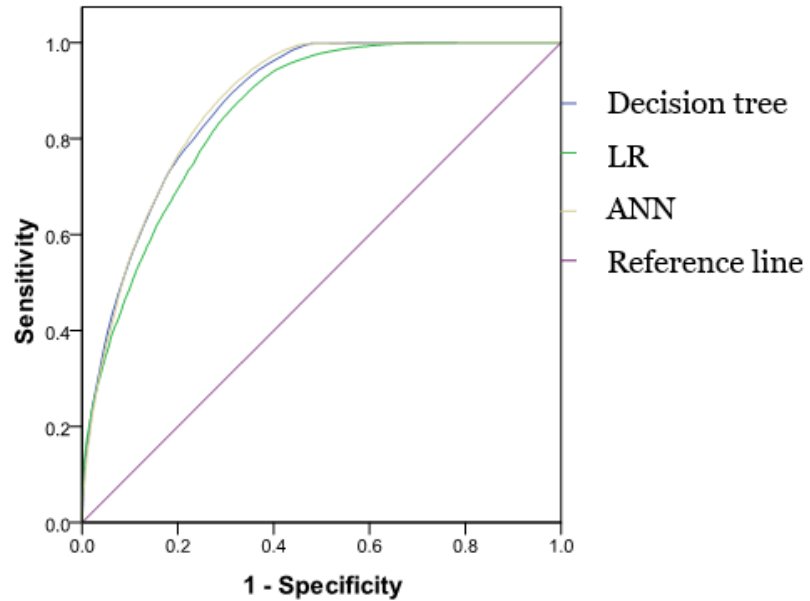
Figure 7. ROC comparison of the logistic regression, artificial neural network and decision tree models